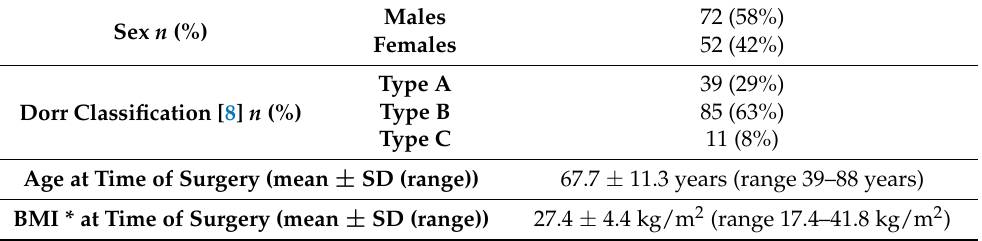
Males Females Type A